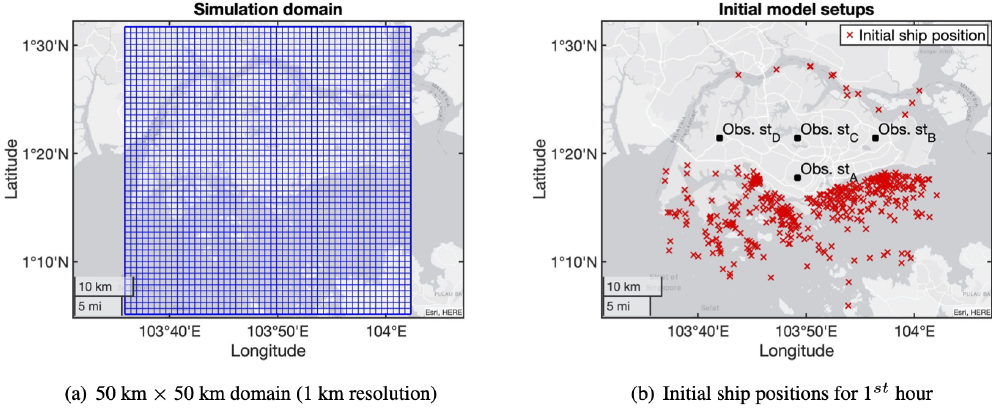
Figure 6. Configuration of the simulation domain used in the real case